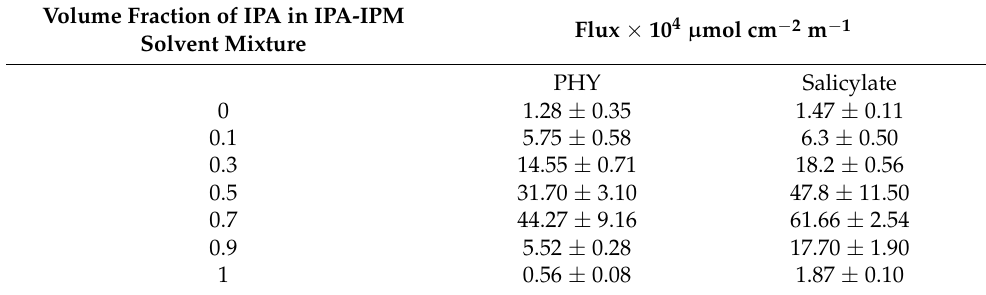
Table 9. Flux values for PHY and salicylate through excised human skin, which according to the authors, were delivered from equimolar saturated solutions of solvents consisting of IPA, IPM and their mixtures ( n ≥ 3 ≤ 8, values represent the mean ± S.E.M.) Adapted from [41], Wiley, 1992.